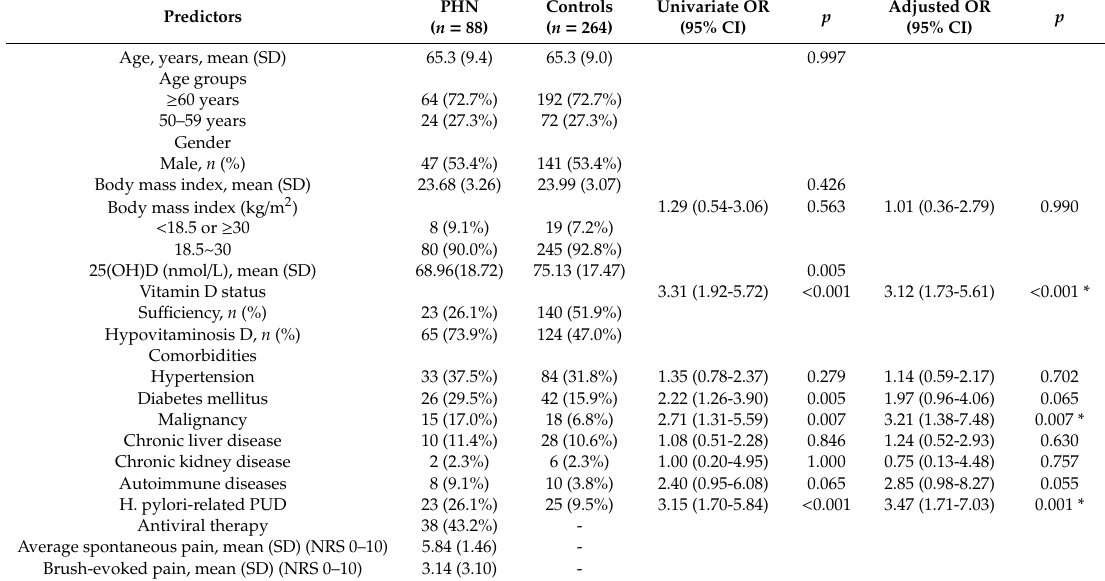
Table 1. Conditional logistic regression analysis of potential predictors for